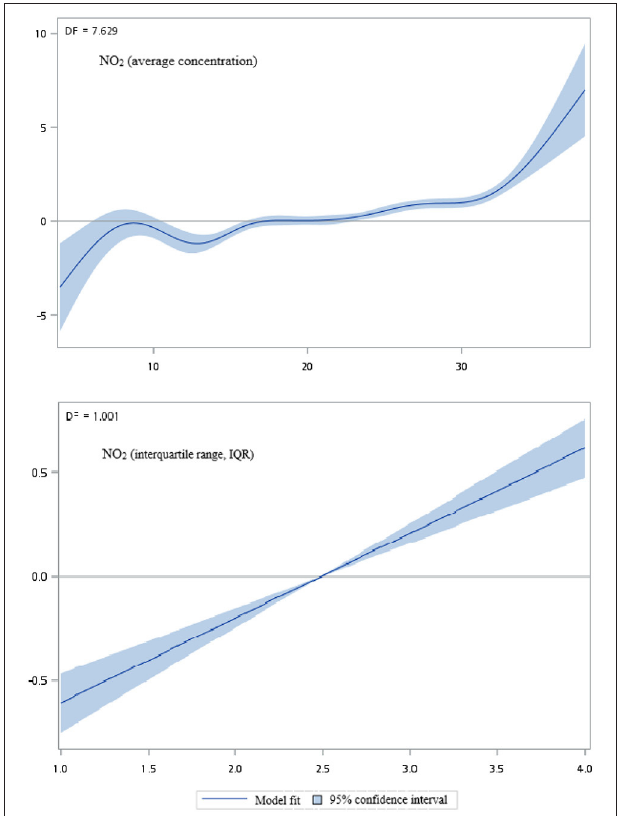
FIGURE 3 | Generalized additive model plot for air pollutions (NO).